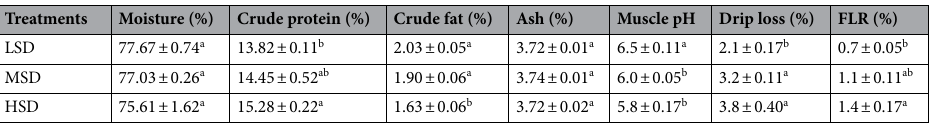
Table 3. Muscle chemical composition and flesh quality of L. rohita stocked at three different stocking densities. Values are mean ± SE. Means in the same column within each classification bearing different superscripts (a, b, c) are significantly different ( P < 0.05). FLR frozen leakage rate, LSD low stocking density, MSD medium stocking density, HSD high stocking density.